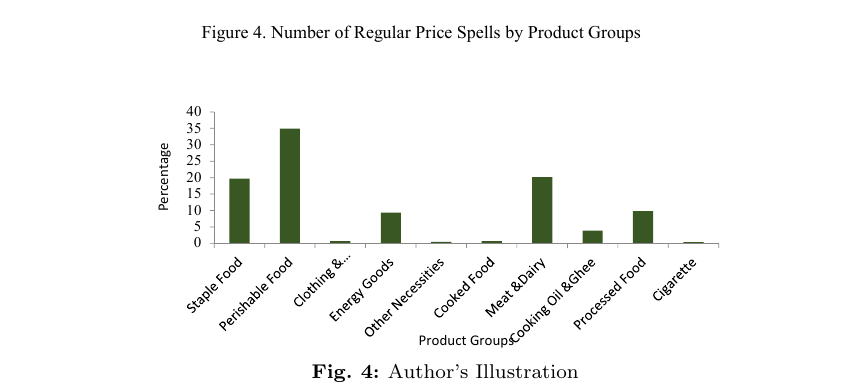
Figure 4. Number of Regular Price Spells by Product Groups